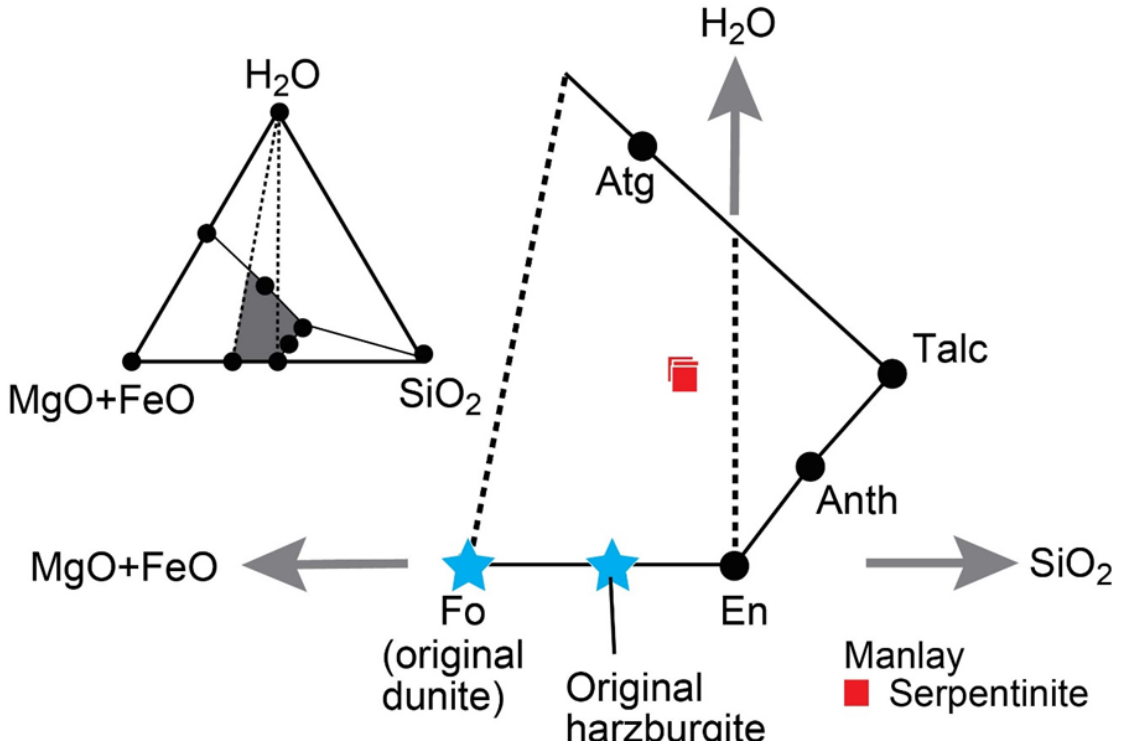
Fig. 5. (MgO + FeO)-SiO -H O ternary diagram based on whole-rock major-element chemistry (wt.%) and loss 2 2 on ignition (LOI, wt.%) values for serpentinites in the Manlay